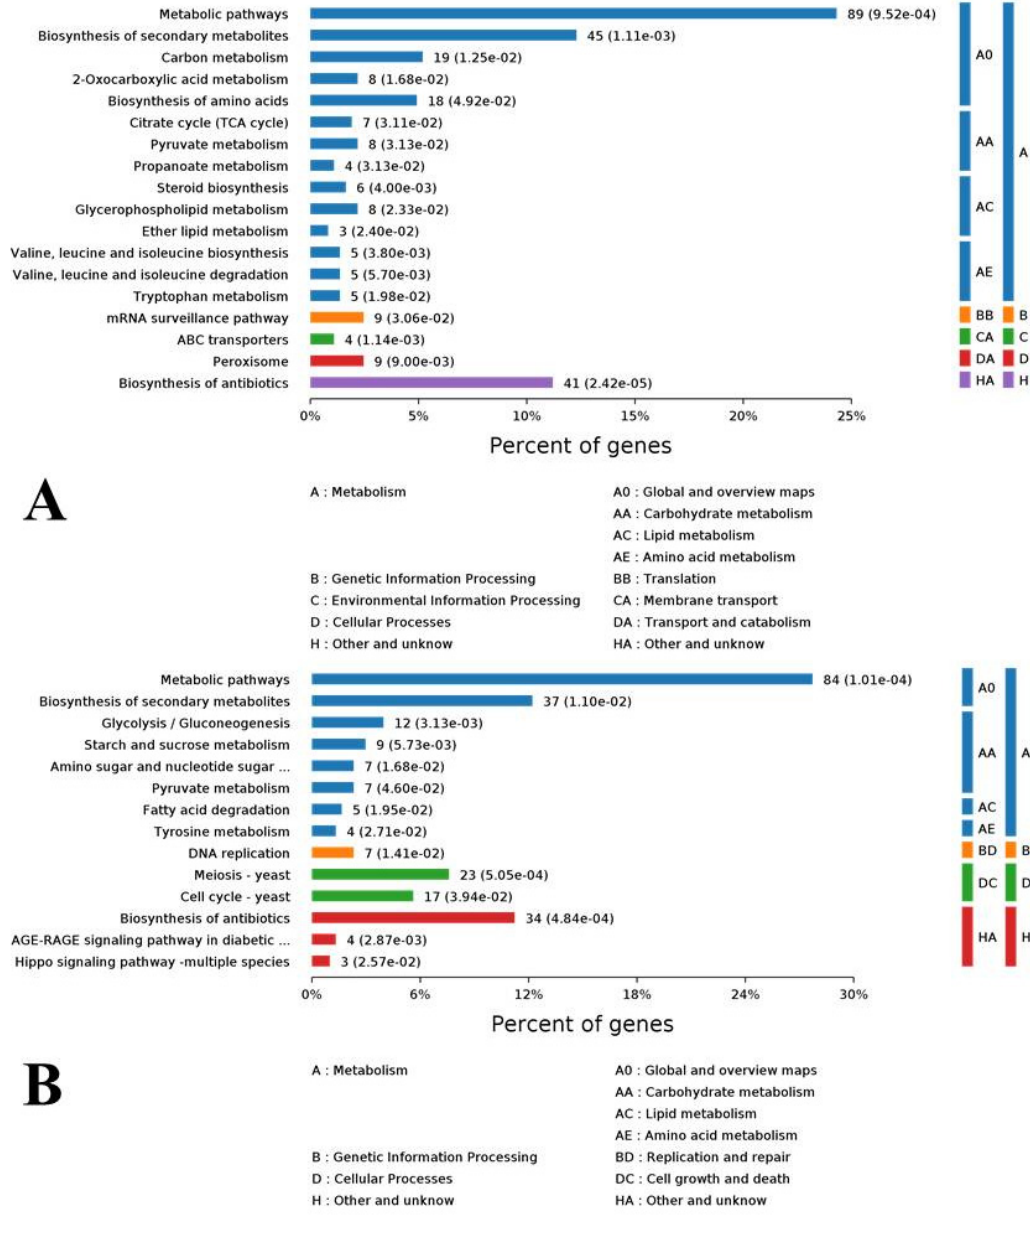
Figure 5. Kyoto Encyclopedia of Genes and Genomes (KEGG) enrichment of differentially expressed genes (DEGs) and hierarchical belonging of each enriched pathway to upper level pathways. (A) Pathway classification of up regulated DEGs. (B) Pathway classification of down regulated DEGs.